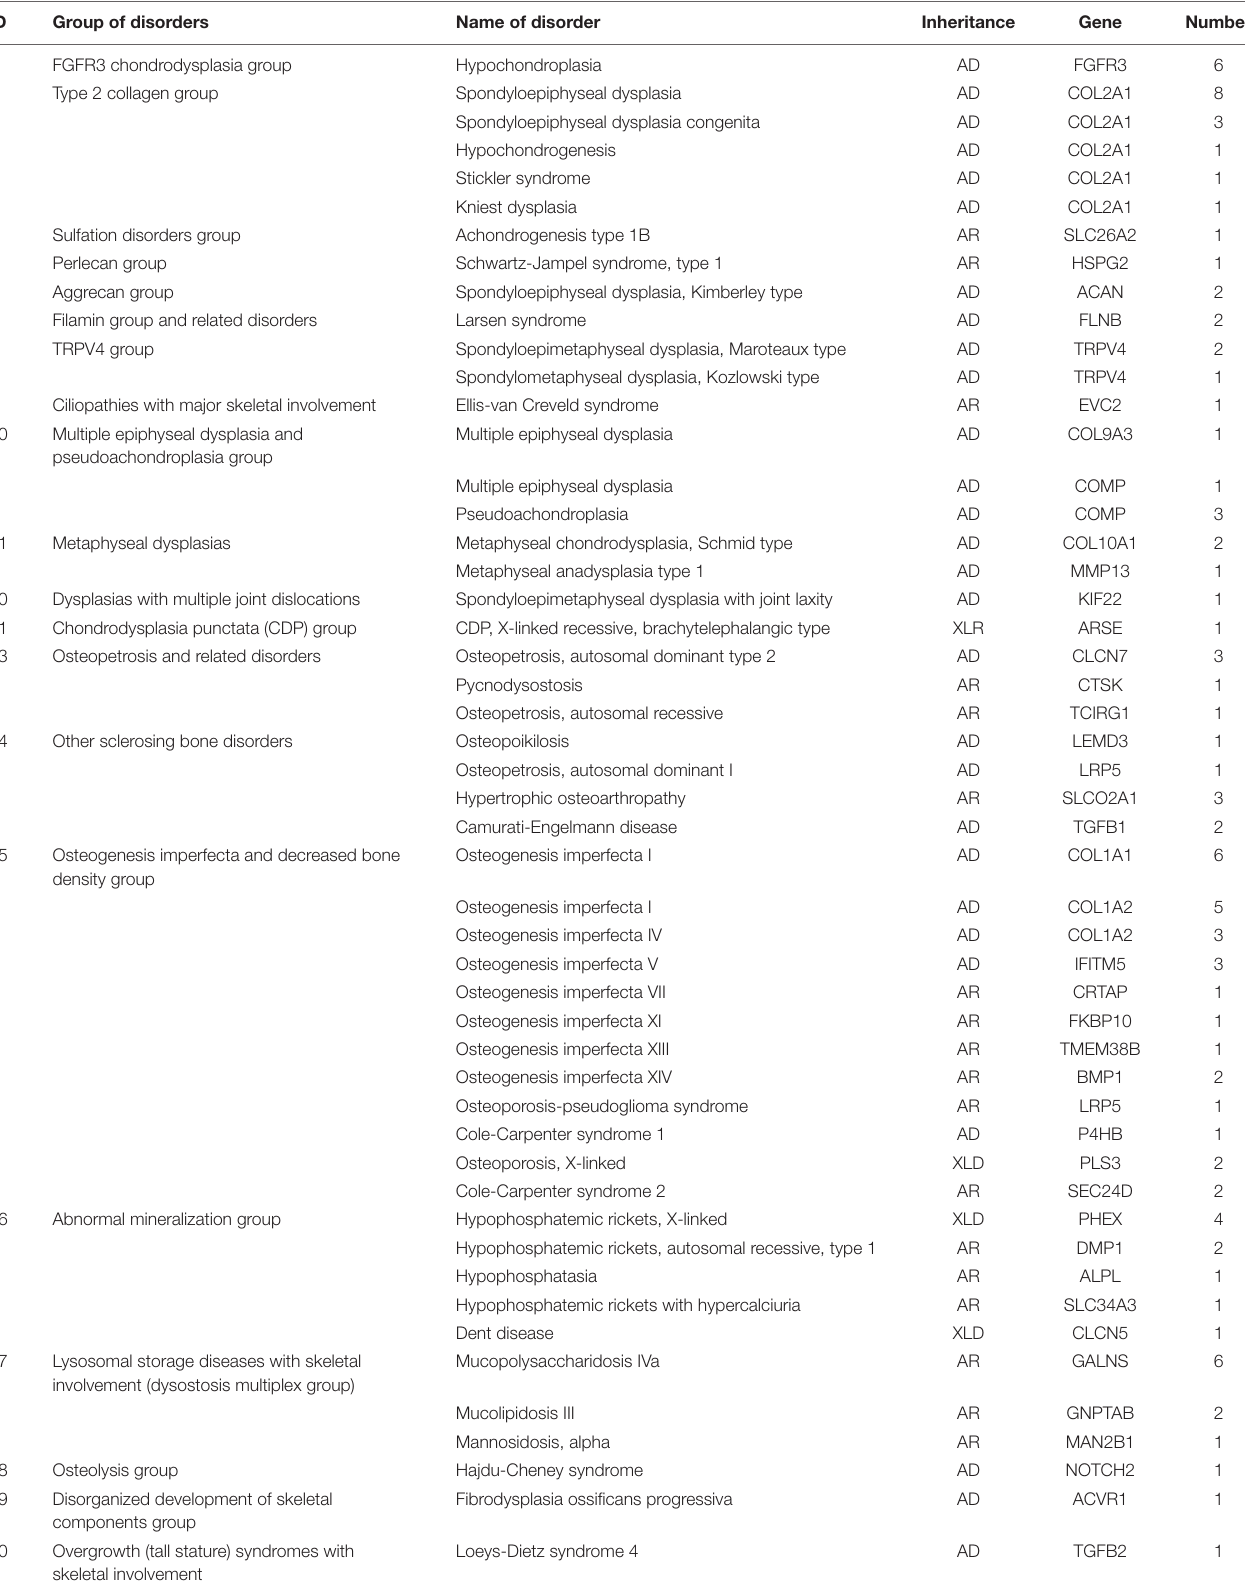
TABLE 2 | Molecular diagnostic classification of 110 probands based on the 2015 revision of the nosology and classification of genetic skeletal disorders.